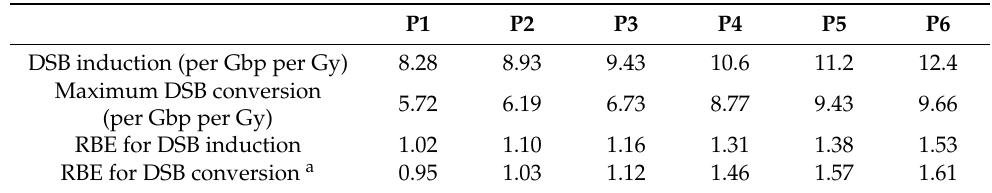
Table 7. The yields of DNA induction, enzymatic DSB and RBE of DSB induction and enzymatic DSB for LP BER